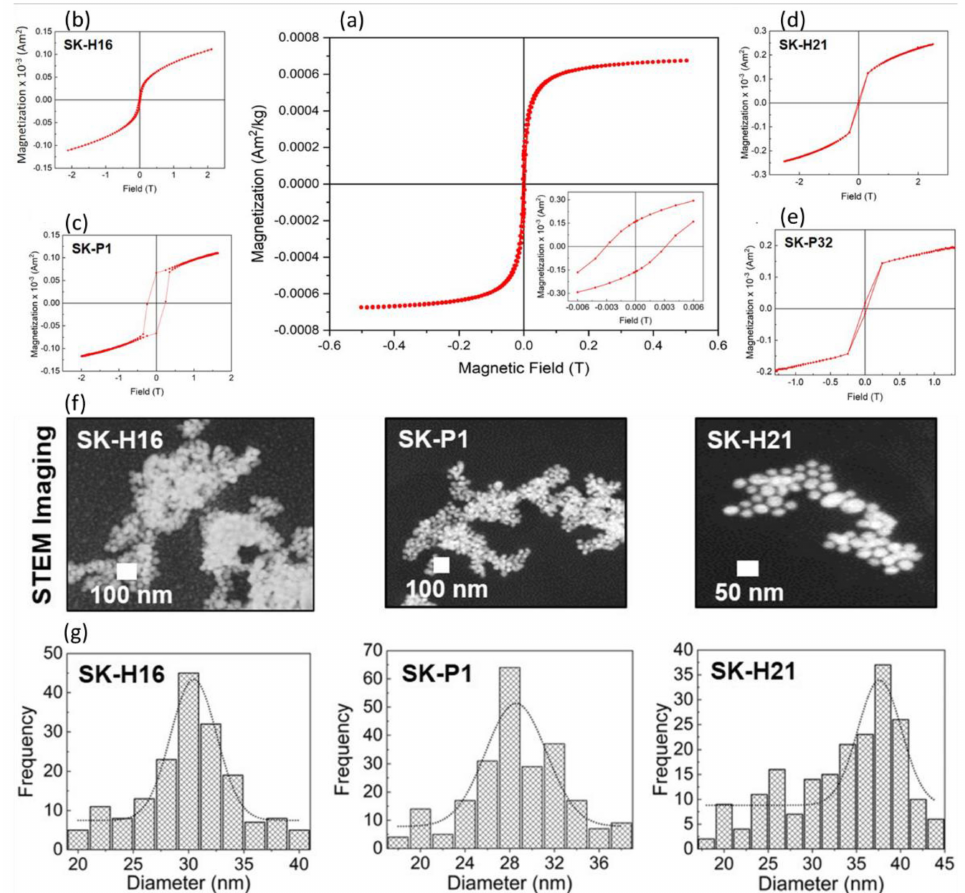
Figure 3. ( a ) Magnetization curve at 300 K of the magnetic nanoparticles synthetized by Pseudomonas aeruginosa ; ( b – e ) Magnetic analysis performed with four bacterial cells evidencing that nanoparticles had a small remanence and coercive fields; ( f ) Transmission electron microscopy images showing the pseudo spherical shape f three isolates; ( g ) The magnetic nanoparticles diameter (size) distribution obtained from the STEM images. Adapted with permission (Creative Commons CC BY license) from